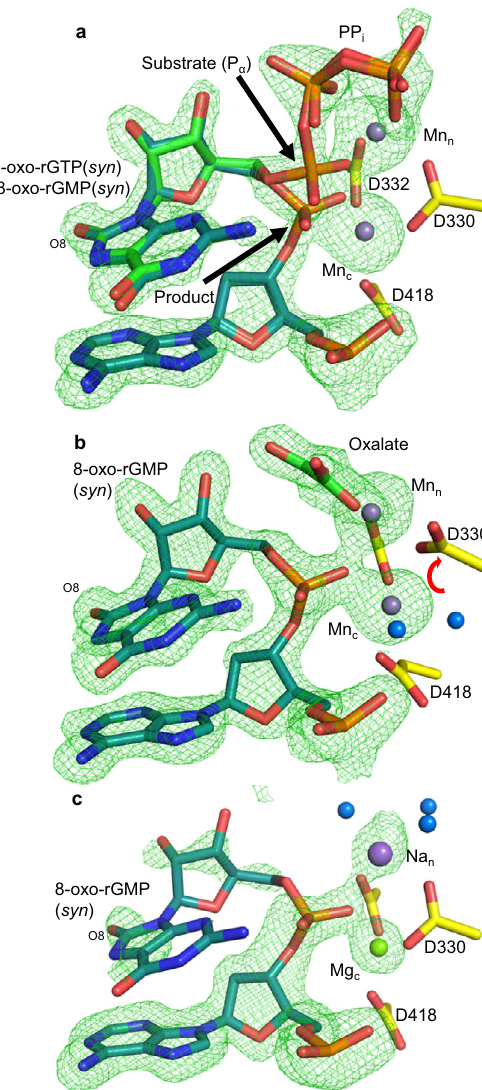
Fig. 5 8-oxo-rGTP(syn) insertion opposite adenine. a Active site of the Mn 2 + -reaction state (RS) ternary complex of pol μ in the process of inserting 8-oxo-rGTP(syn) opposite A t . Arrows indicate bond broken (substrate) and formed (product). Protein sidechains are shown in yellow stick representation, the incoming nucleotide is green and DNA is cyan. Mn 2 + atoms are shown as magenta spheres. Simulated annealing omit density is shown as a green mesh contoured at 3 σ . b Active site of the 8- oxo-rGMP(syn):A t Mn 2 + -product (PS) complex. A red arrow indicates rotation of Asp330 compared to the ground and reaction states. Water molecules are shown as blue spheres. c Post-catalytic (960 min) Mg 2 + :8- oxo-rGMP(syn):A t product (ES) complex. The larger purple sphere is Na + , while Mg 2 + is a green coordinated by P γ , an altered His329 and three water molecules (Fig. 4c, Supplementary Fig. 5c, Supplementary Table 4). Snapshots of insertion opposite adenine . A differential effect of the 2´OH group on the ef fi ciency of 8-oxo-rGTP:A t and 8-oxo- dGTP:A t insertions (<10-fold) was not apparent based on kinetic analysis (Fig. 2a, Supplementary Tables 1, 2). While 8-oxo-rGTP